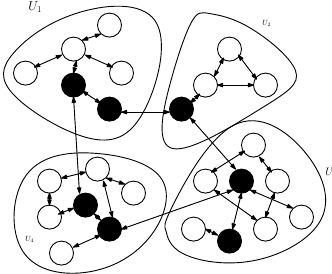
Figure 2. Network partitioned in 4 subsets. Super-nodes are depicted in black.